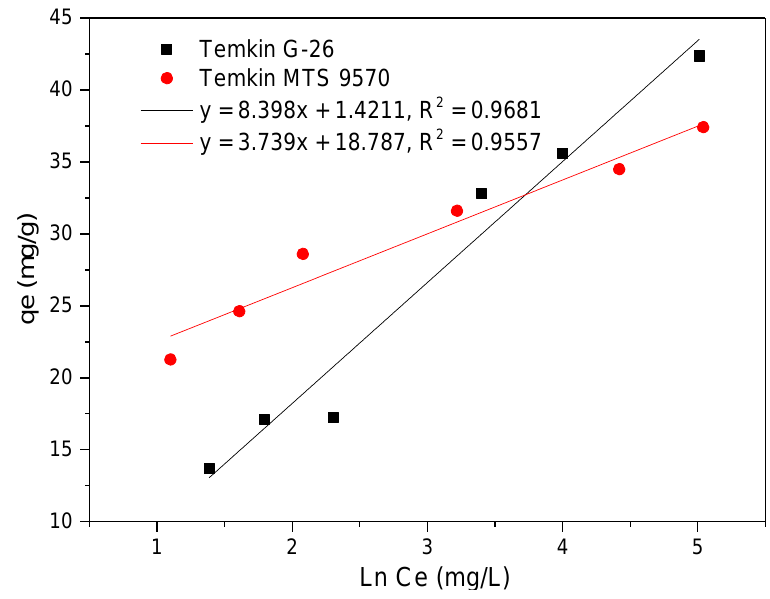
Figure 10. Temkin isotherm of Pb(II) adsorption on G-26 and MTS9570. The maximum adsorption capacities of G-26 and MTS 9570 resins are excellent com- Table 2. The isotherm parameters for Pb(II) adsorption on G-26 and MTS9570. pared with some other adsorbents for the adsorption of Pb(II) ( Table